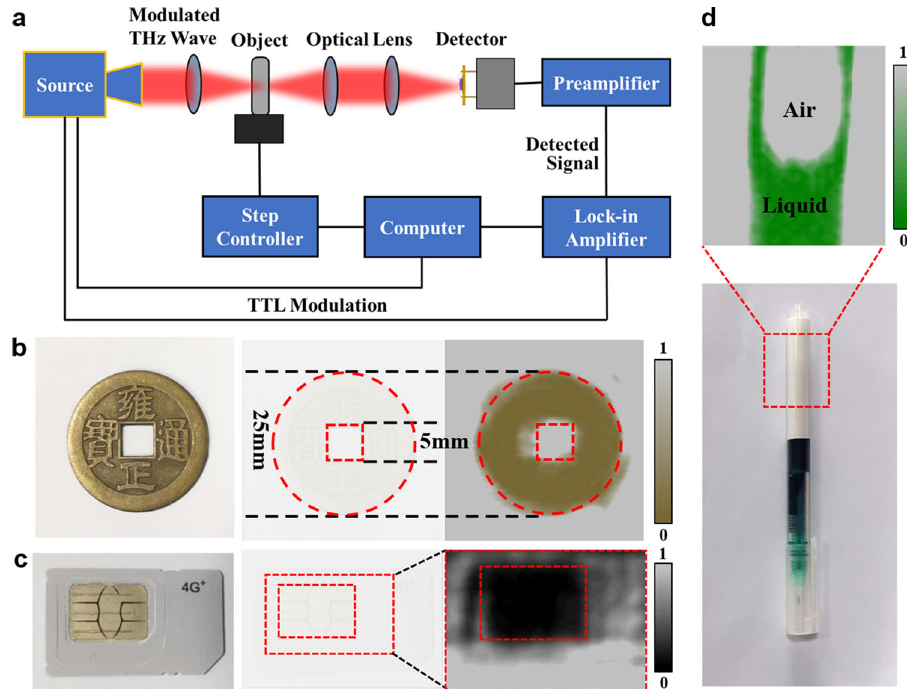
Fig. 5 THz transmission imaging experiments. a Schematic of the setup used for the THz detection and imaging. b Photo picture of a copper coin and its THz image. c Photo picture of a sim card and its THz image. d Photo picture of a pen and THz image of ink capacity of the